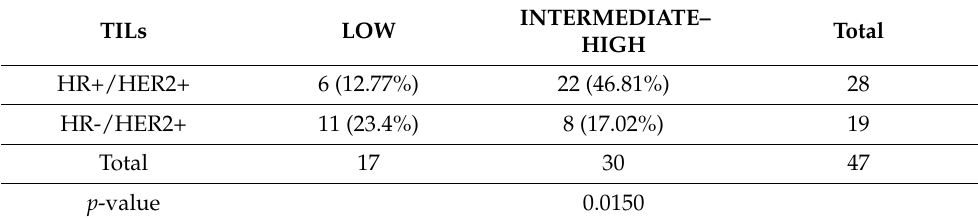
Table 5. Relation between TILs and hormone receptors.